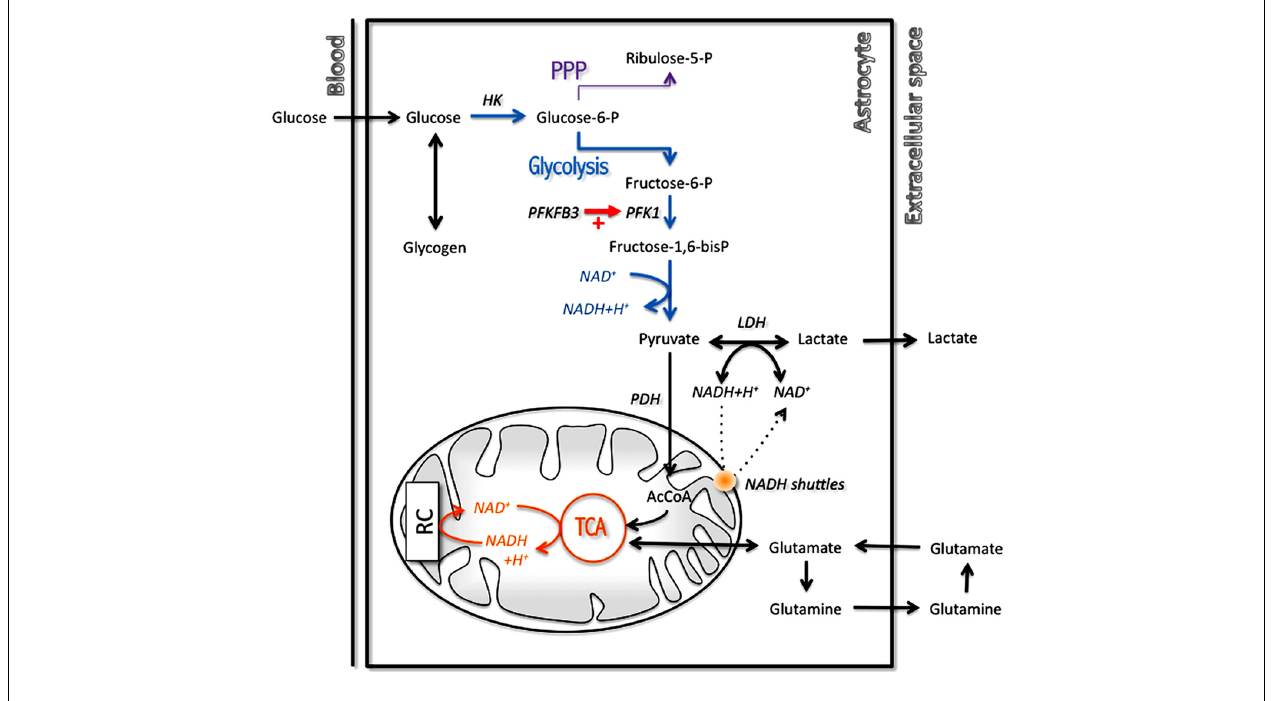
FIGURE 3 | Main metabolic pathways implicated in energy production in astrocytes with a prominent role for glycolysis. In order to regenerate cytosolic NAD + levels and maintain glycolytic rate, astrocytes have two options: transfer cytosolic NADH in mitochondria through specific mitochondrial NADH shuttles or convert pyruvate into lactate